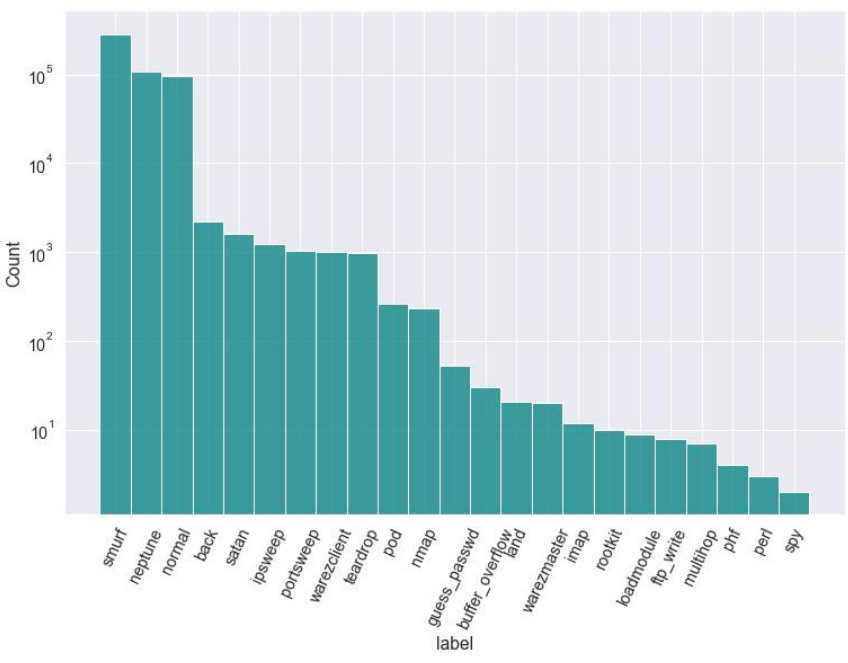
Figure 1. Distribution of connection types before removal of